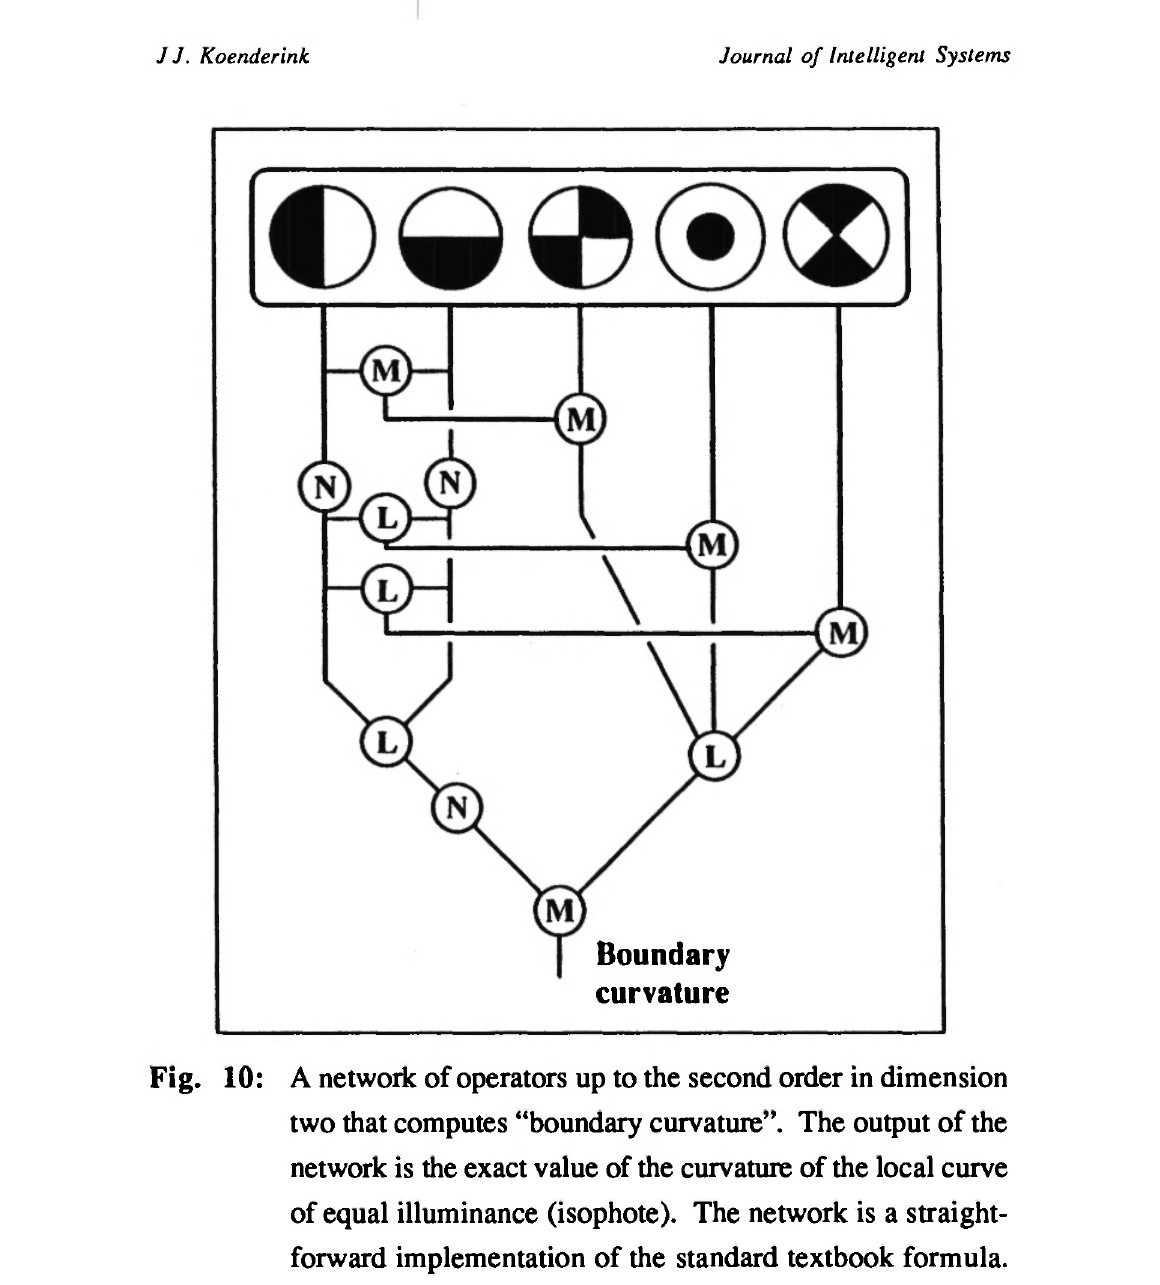
Boundary curvature Fig. 10: A network of operators up to the second order in dimension two that computes "boundary curvature". The output of the network is the exact value of the curvature of the local curve of equal illuminance (isophote). The network is a straight- forward implementation of the standard textbook formula. Please notice that the operators are to be thought of as spa- tially coincident. They have been separated for the sake of clarity in this figure. The nodes are: M: multiplicative com- bination, L: additive (linear) combination, N: nonlinear